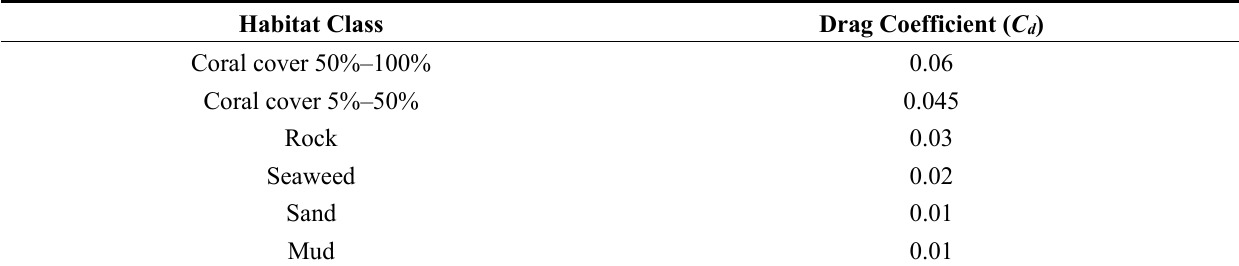
Table 3. The drag coefficient for the habitat classes composing Japanese coral reefscapes (derived from